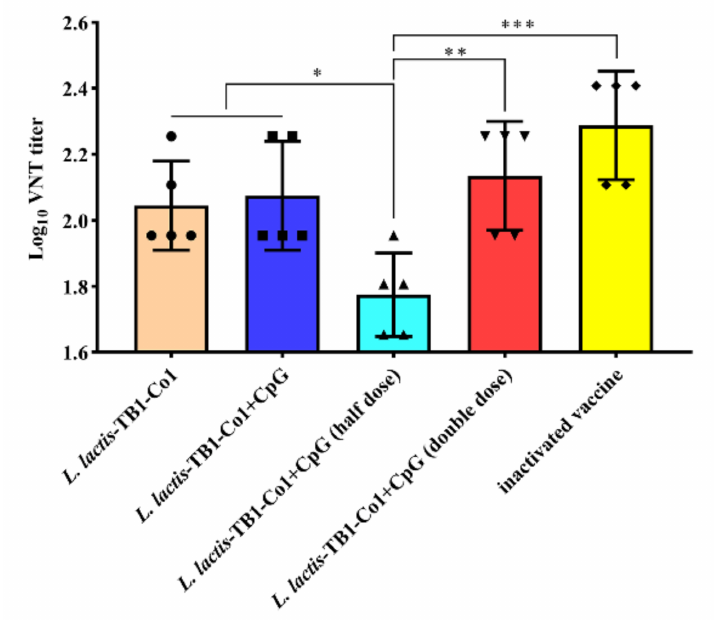
Figure 7. Titers of FMDV-specific neutralizing antibodies in guinea pigs. Data were calculated as log 10 of max serum dilution that neutralized 100 TCID 50 of FMDV strain AF72. Error bars show SD. Analyses were performed by t tests (NS = p > 0.05; * p < 0.05; ** p < 0.01; *** p < 0.001).